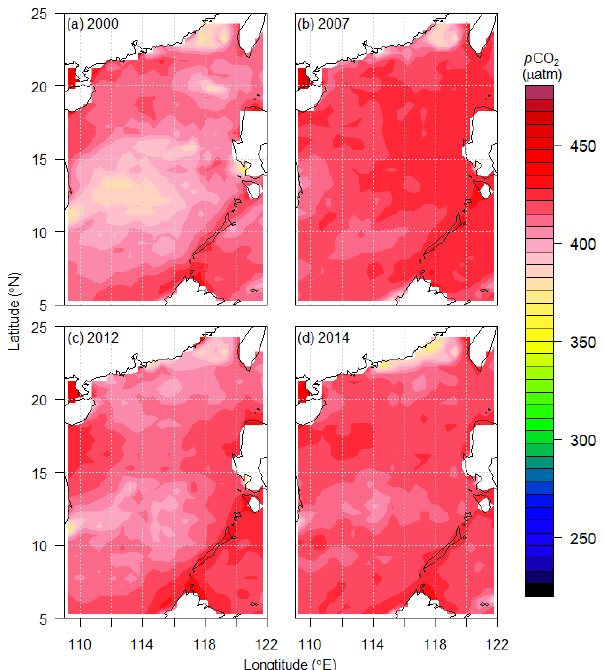
Figure 4. Remote-sensing-derived sea surface p CO 2 in summer in selected years from 2000 to